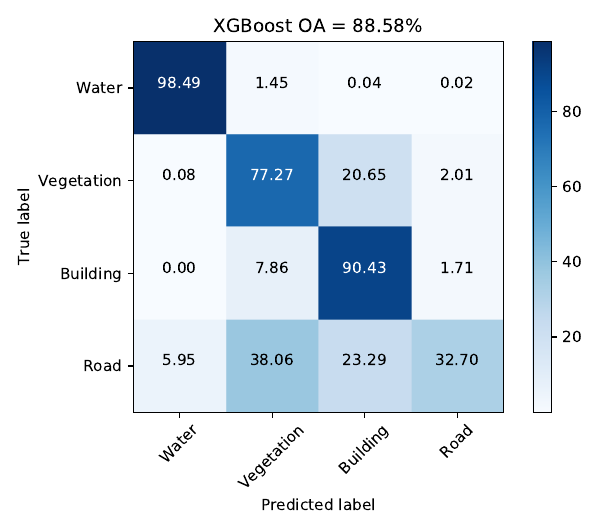
Figure 18. Confusion matrix for data set A with four classes.